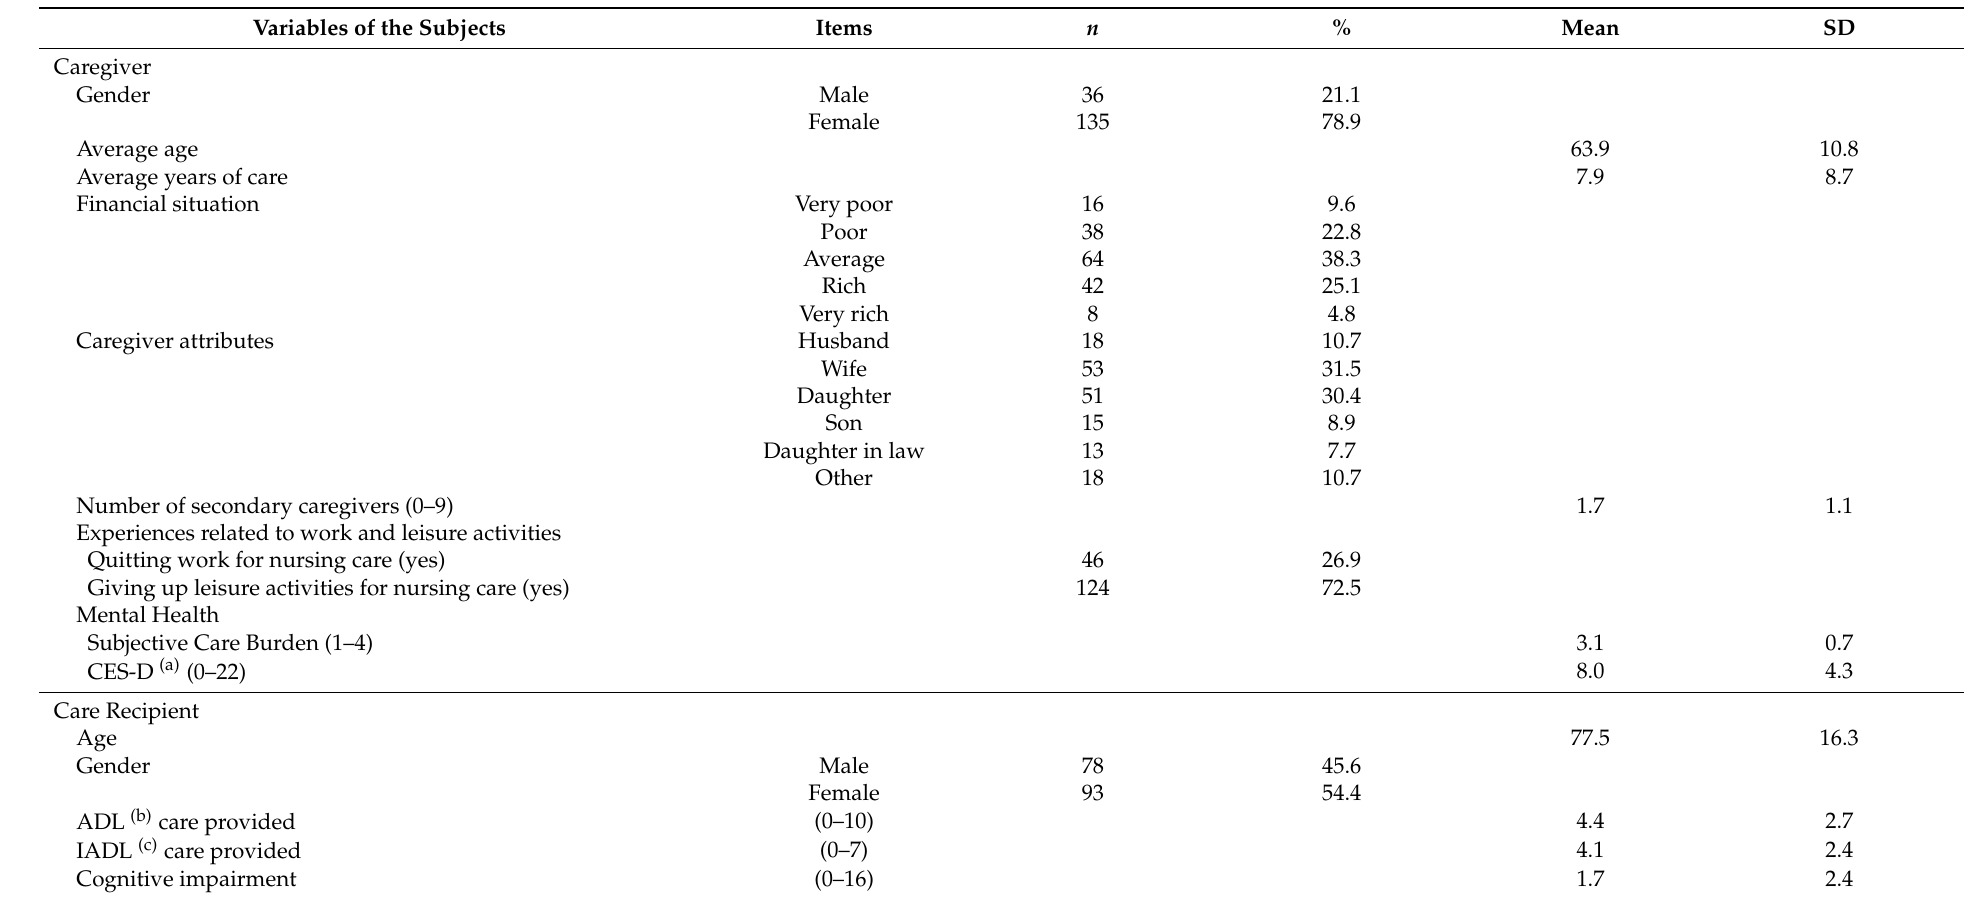
Table 1. Demographic characteristics of the participants ( n =